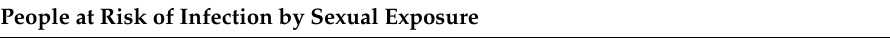
Table 2. Recommendations for adult vaccination with hepatitis B